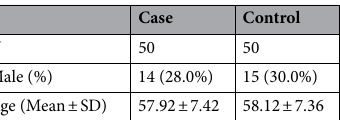
Table 1. Age and gender information in the two groups after propensity score matching.